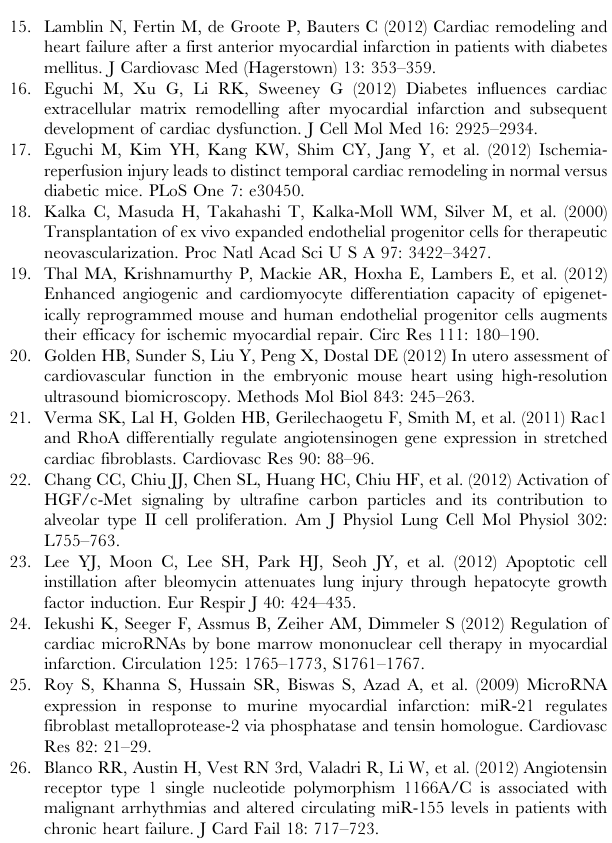
Figure S4 Expression of cardiac miRNAs after intra- myocardial BMPC transplantation following MI in mice. miRNA expression was measured in the border zone of infarcted area at 3 days post-MI by quantitative RT-PCR. BMPC therapy did not affect miR-27 ( A ) and miR-30a ( B ) in comparison with saline-treated group. BMPC, bone marrow-derived progenitor cell; MI, myocardial infarction. (TIF) Figure S5 Administration of mouse recombinant HGF provided cardiac protection after MI. ( A ) HGF administra- tion reduced miR-155 expression, enhanced LV function (in- creased % EF) ( B ) and inhibited fibrosis ( C ). *P value versus saline- treated MI mice. Figure S6 Transplantation of BMPC transfected with siRNA against HGF in mice after MI. ( A ) miR-155 expression, percent ejection fraction (% EF) ( B ) and % fibrosis ( C ) in mice receiving intramyocardial BMPC transfected with siRNA against HGF after MI. *P , 0.05 versus control siRNA BMPC-treated MI mice.